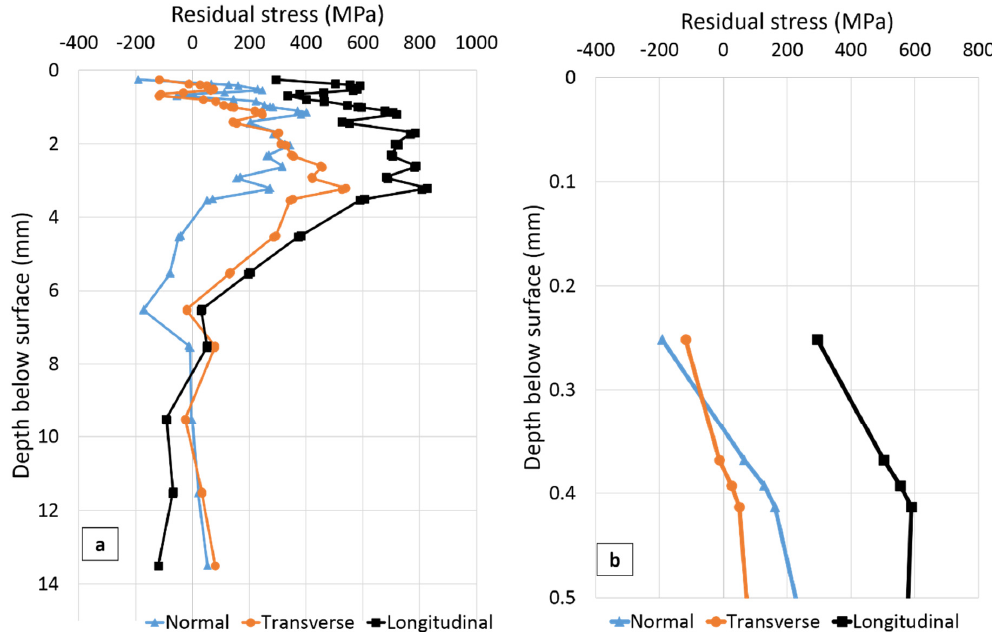
Figure 7. ( a ) Residual stresses as function of distance below the plate surface on the second welded side 2 mm away from the weld toe (SS-HAZ in Figure 4); ( b ) Residual stress from surface to 0.5 mm below the surface.